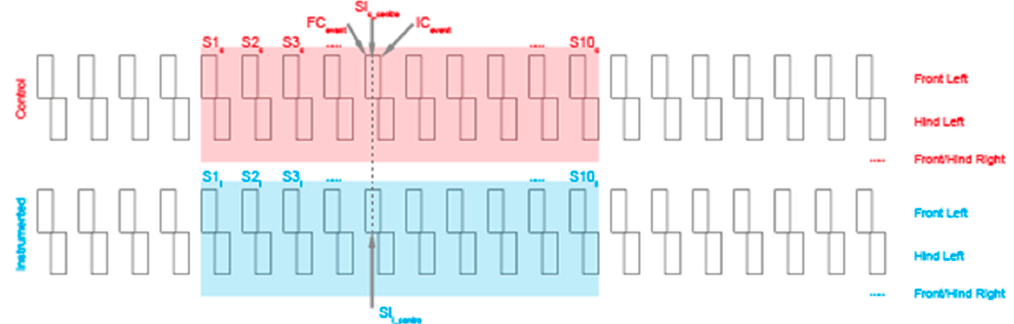
Figure 5 . Approach for determining agreement between prediction and annotation. Figure 5. Approach for determining agreement between prediction and